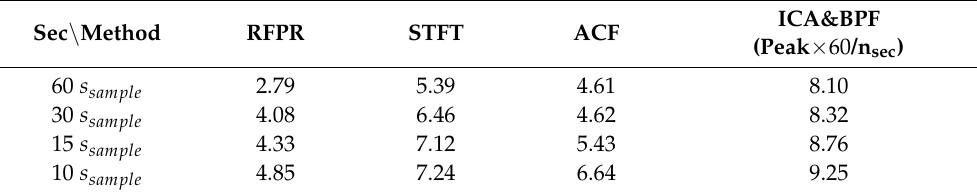
Table 4. MAPE (%) of the short-time FHR on indoor dataset.